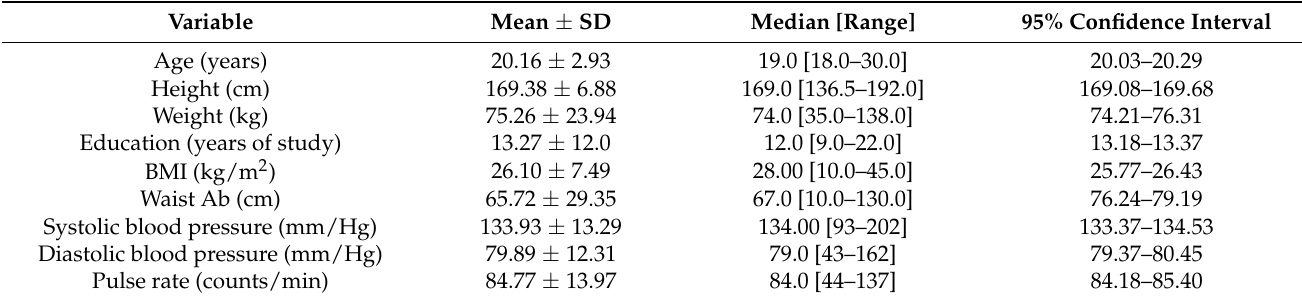
Table 1. Anthropometric and demographic characteristics of study subjects.